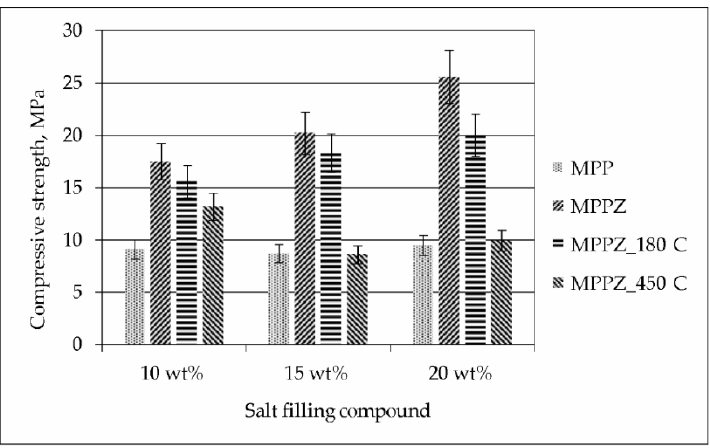
Figure 4. Compressive strength of the MPP compound containing LiCl-KCl-CsCl and 28.6 wt% zeolite.